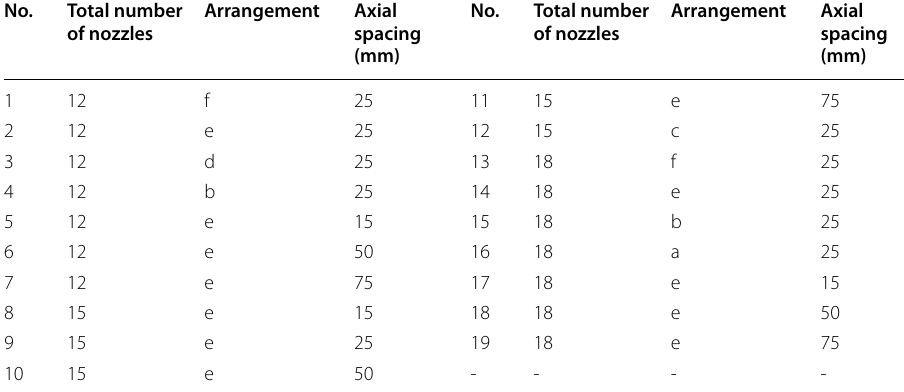
Table 3 Experimental scheme for simulation and analysis of layout No. Total number of nozzles